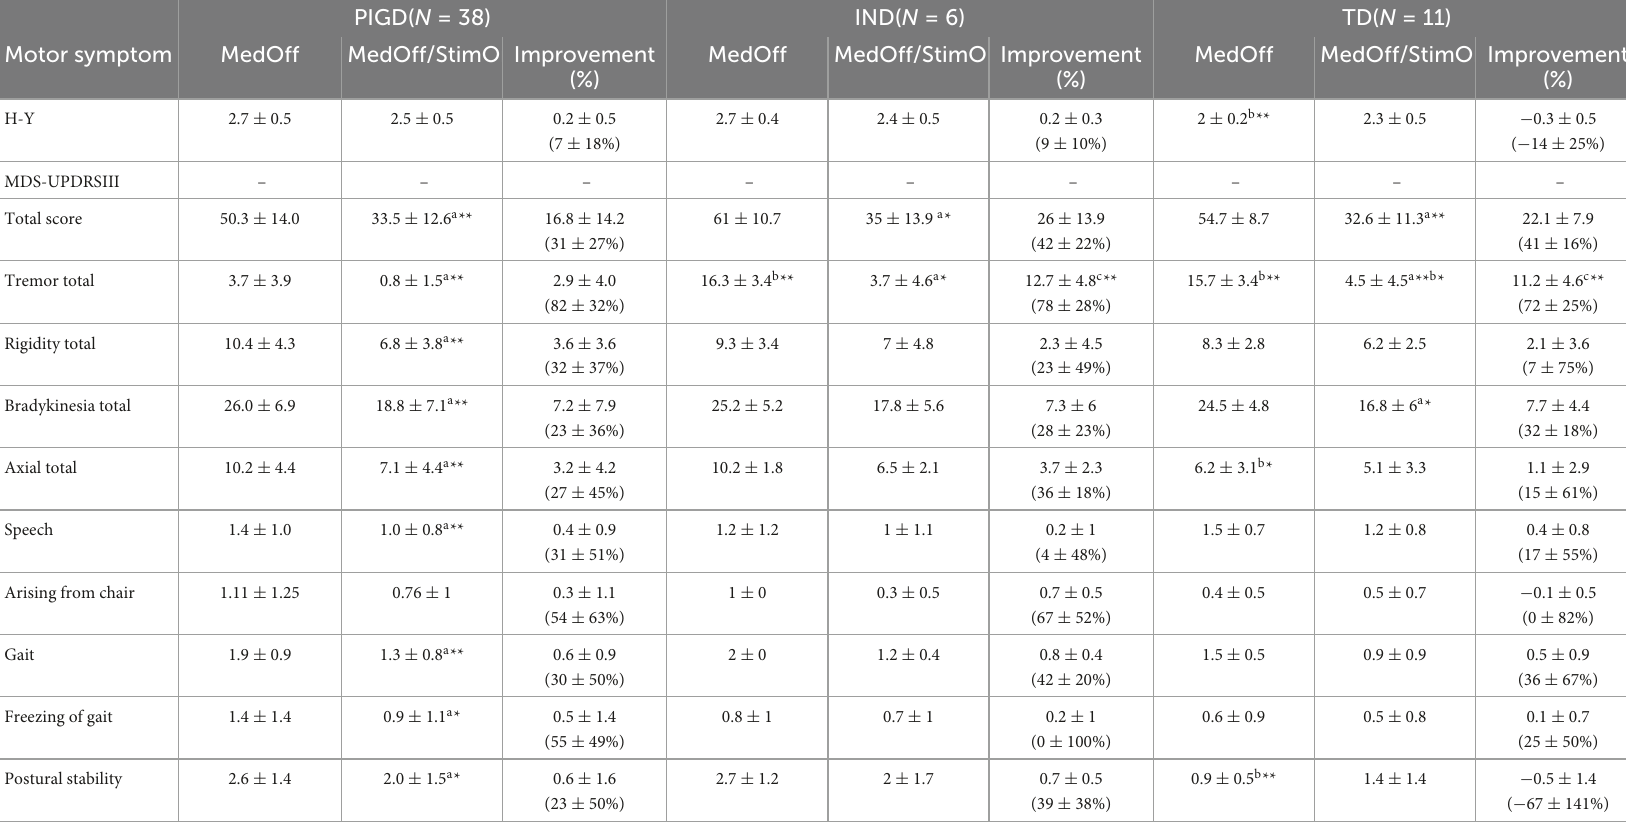
TABLE 4 Deep brain stimulation (DBS) outcomes of different motor